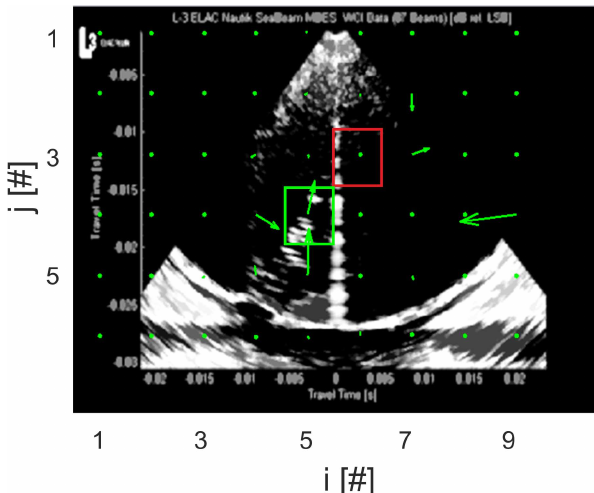
Fig. 4. Mean subtracted image similar to Fig. 2 superimposed with the pixel displacement vector (green arrow) composed of x and z displacements calculated for each interrogation window ( i,j) . Green and red rectangles indicate the “on” and “off” seepage inter- rogation window, respectively.